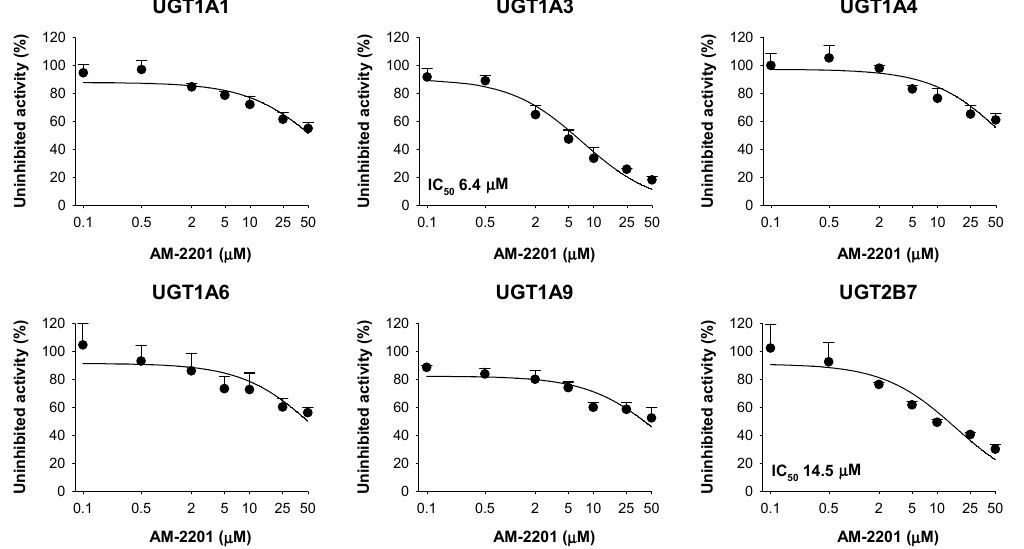
Figure 4. Inhibitory effect of AM-2201 on six UGT metabolic activities in ultrapool human liver microsomes with IC 50 values. Cocktail substrate concentrations used for the assessment of IC 50 were as follows: 0.5 μ M SN-38 for UGT1A1, 2 μ M chenodeoxycholic acid for UGT1A3, 0.5 μ M trifluoperazine for UGT1A4, 1 μ M N -acetylserotonin for UGT1A6, 0.2 μ M mycophenolic acid for UGT1A9, and 1 μ M naloxone for UGT2B7. Data represent the mean ± SD ( n = 3). AM-2201 negligibly inhibited UGT1A1-catalyzed SN-38 glucuronidation, UGT1A4-catalyzed